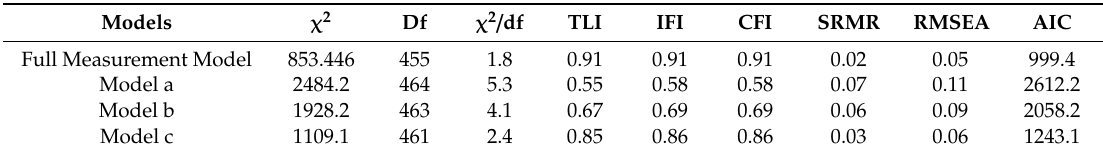
Table 1. Fit Statistics of Measurement Model Comparison.